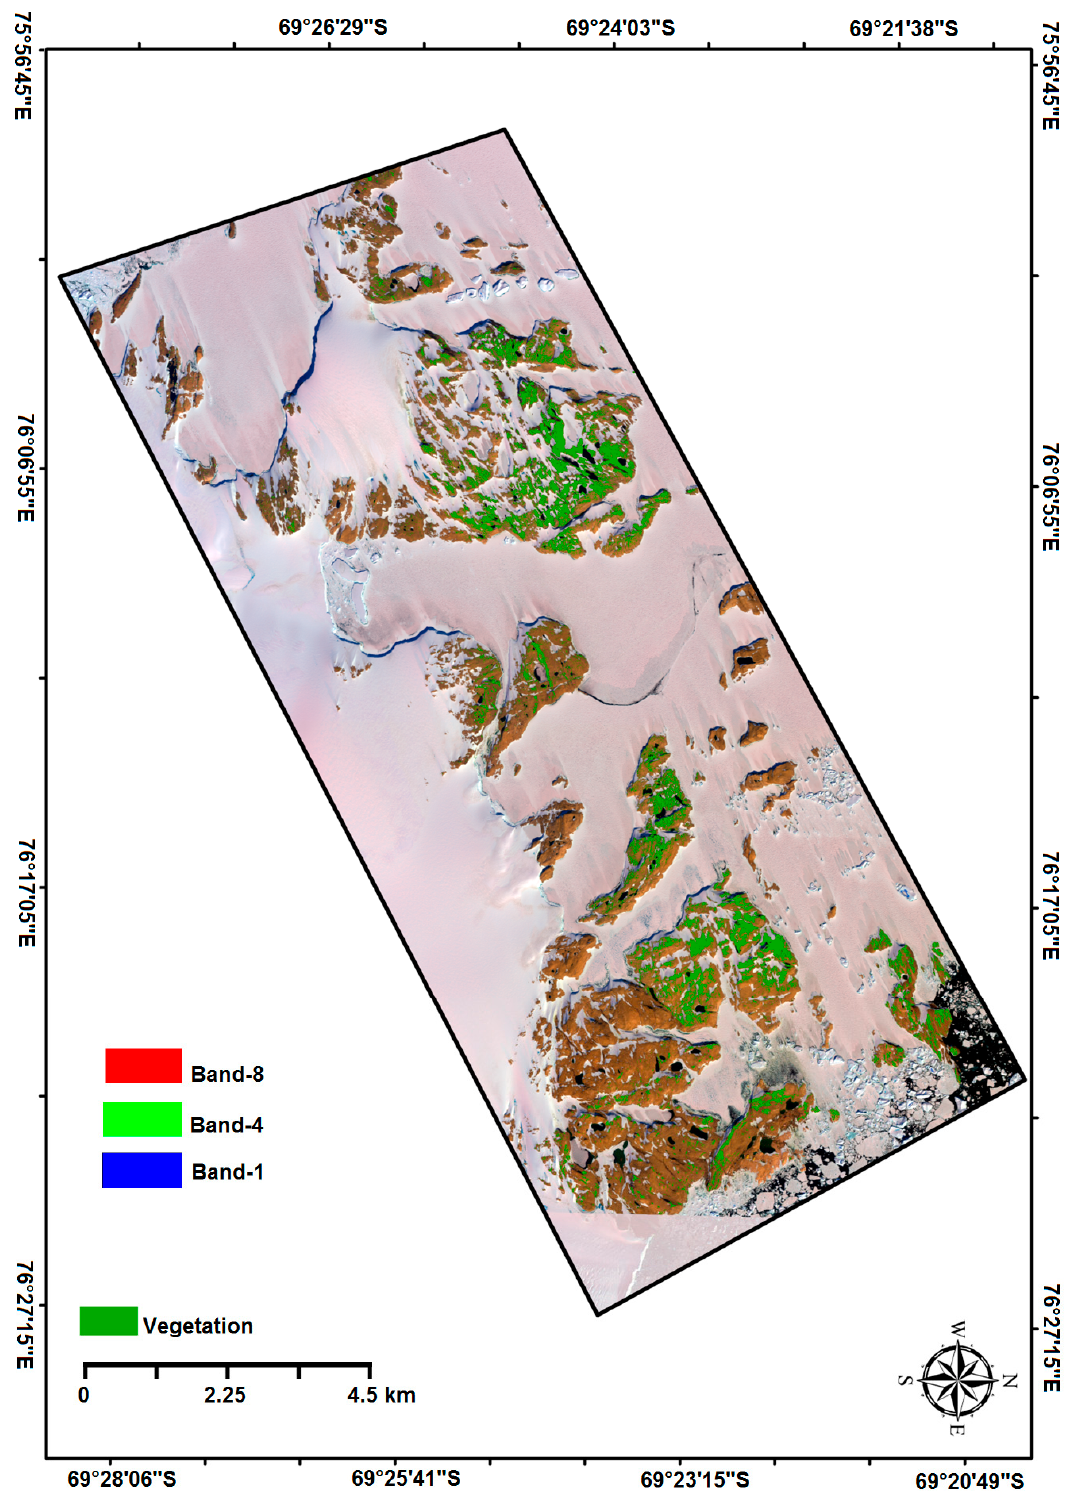
Figure 9. The vegetation cover map of Larsemann Hills and environs derived using ensemble (winner-takes-all / majority consensus) merging of the five top-performing methods [Mixture Tuned Matched Filtering (MTMF), Matched Filtering / Spectral Angle Mapper ratio (MF / SAM), Matched Filtering (MF), normalized di ff erence vegetative index (NDVI)-2, and NDVI-4)]. Map prepared